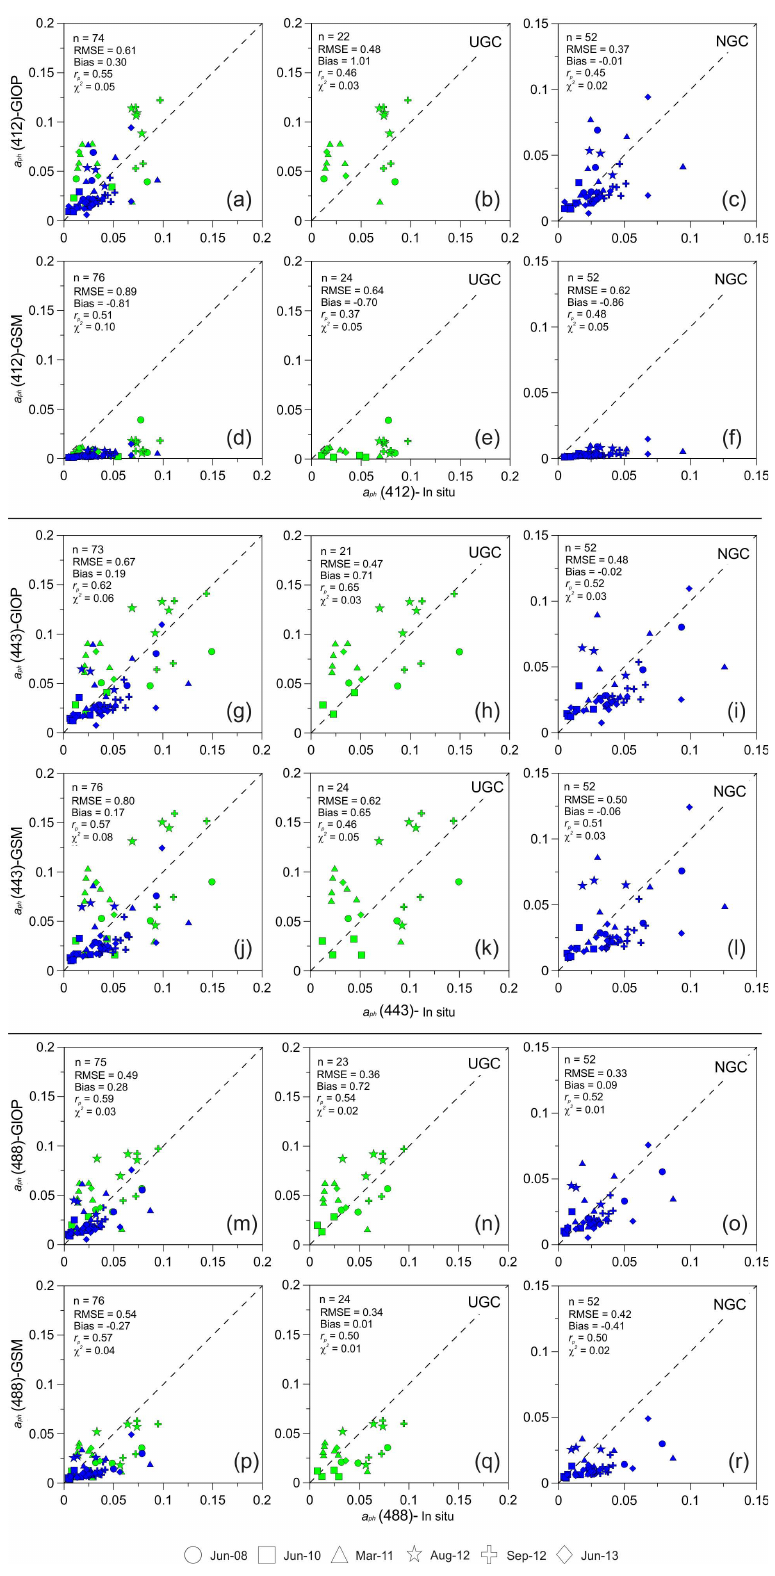
Figure 3. Comparative analysis between in situ and satellite a ph (412, 443, and 488 nm) for GIOP and GSM models, with the statistics Root Mean Square Error (RMSE), bias, r p , and χ 2 ; the 1:1 line is indicated for reference. The green and blue colors correspond to the UGC and NGC regions, respectively. In the first column ( a , d , g , j , m , p ) the entire database was used, in the second ( b , e , h , k , n , q ) only data from UGC, and in the third ( c , f , i , l , o , r ) only data from